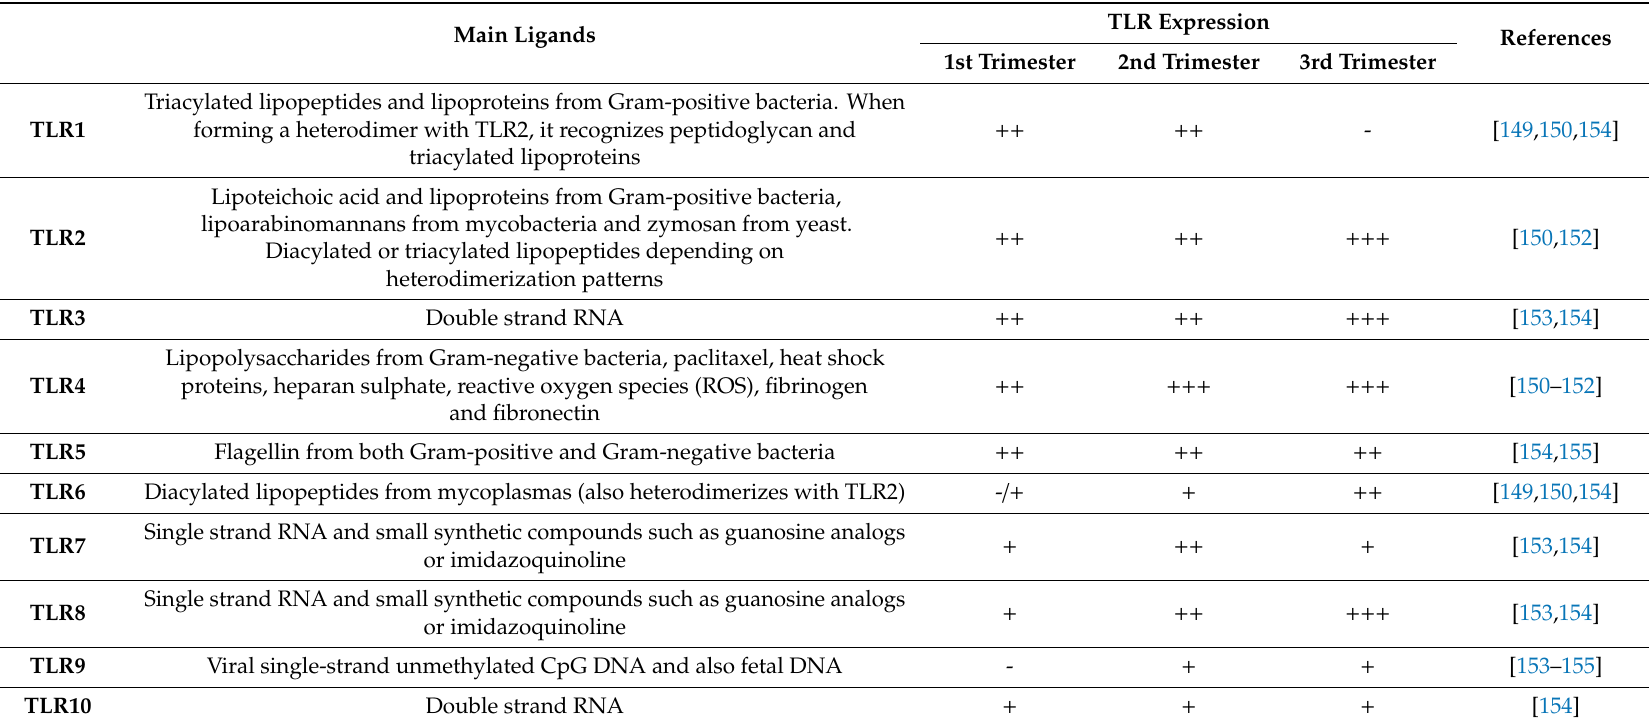
Table 1. TLRs’ temporal patterns of expression in human